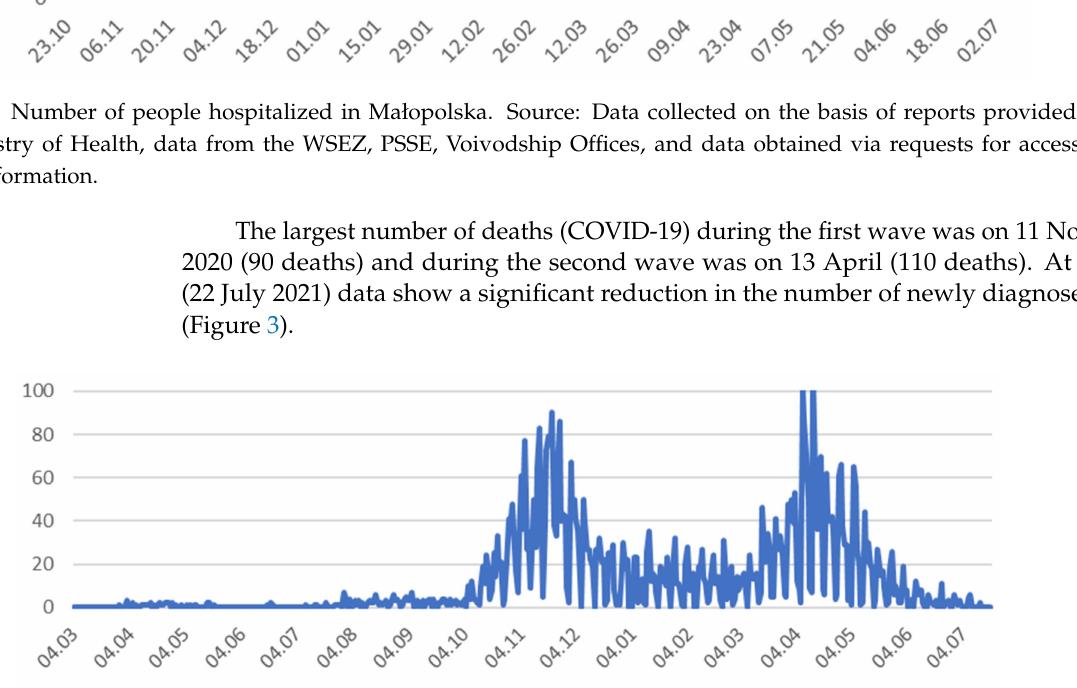
Figure 3. Number of deaths (COVID-19) in Małopolska. Source: Data collected on the basis of reports provided by the Ministry of Health, data from the WSEZ, PSSE, Voivodship Offices, and those obtained in requests for access to public